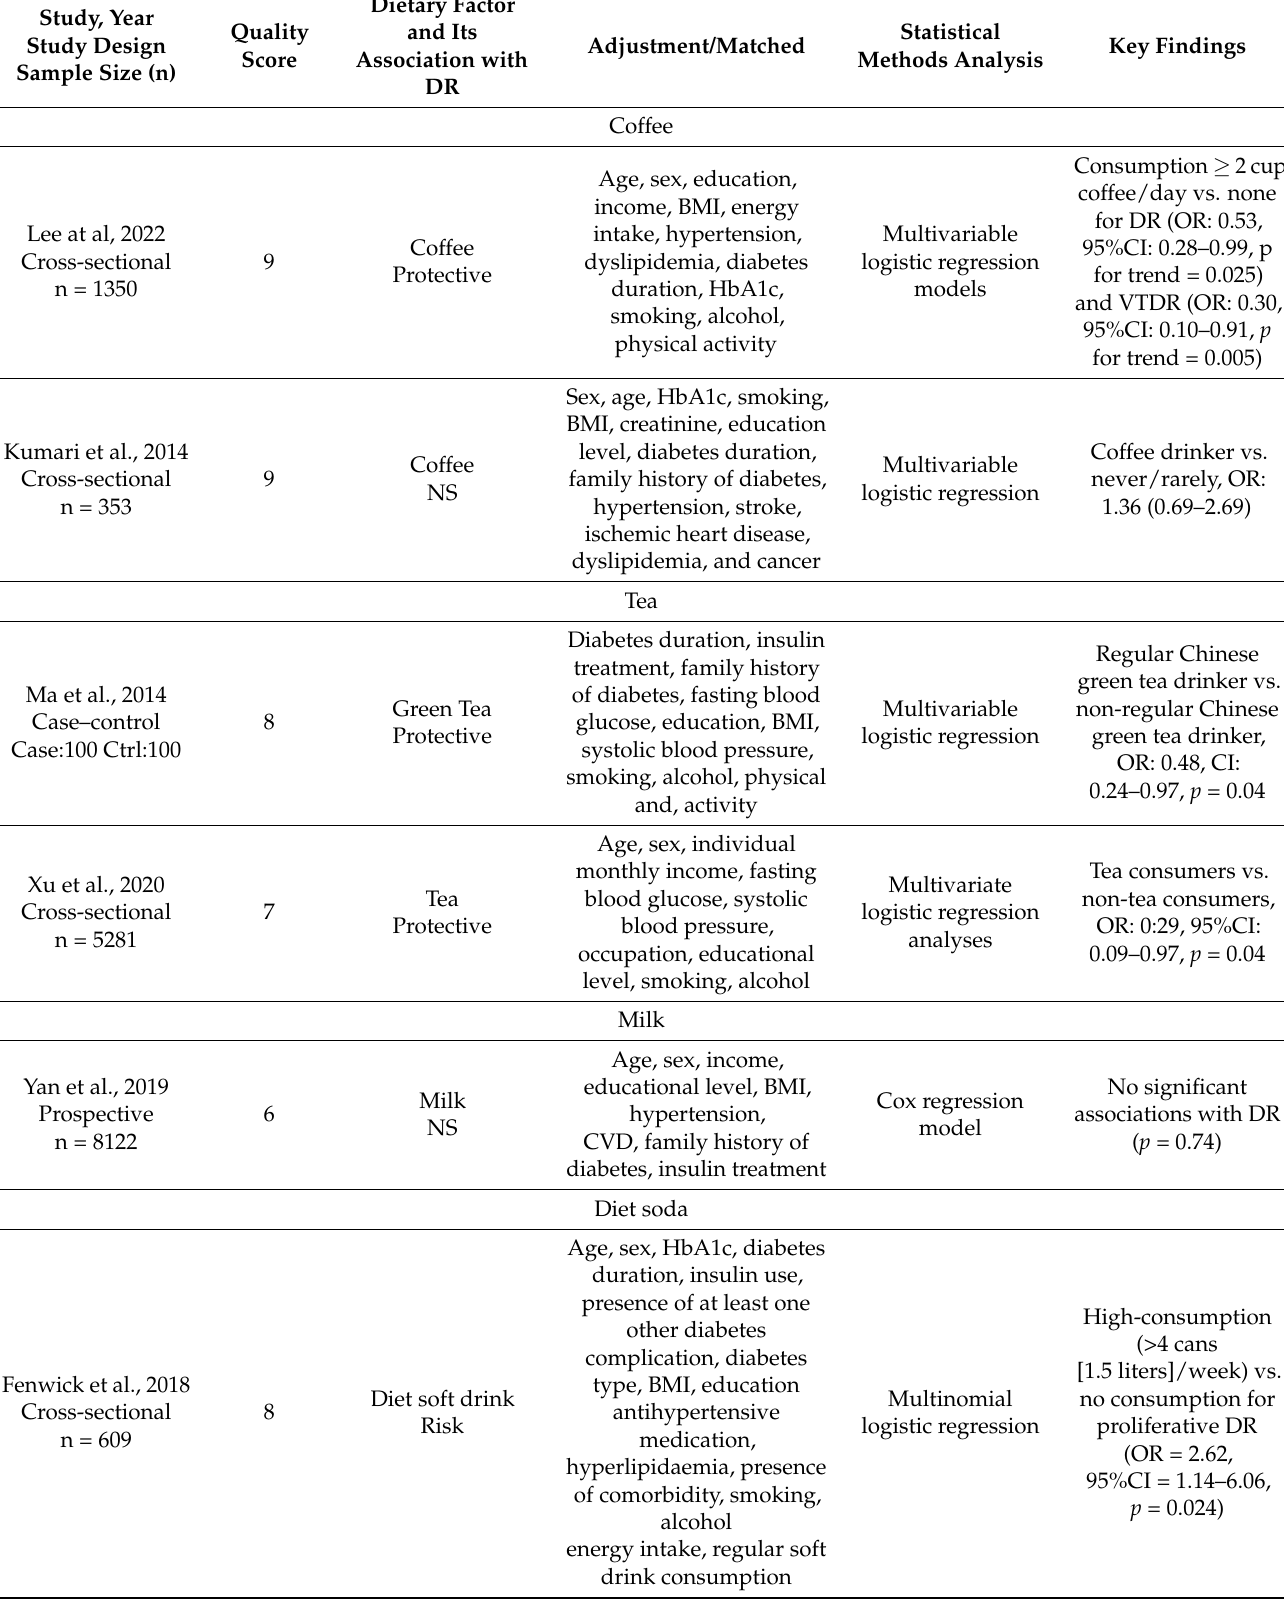
Table 5. Dietary intake of beverages, dietary patterns, and diabetic